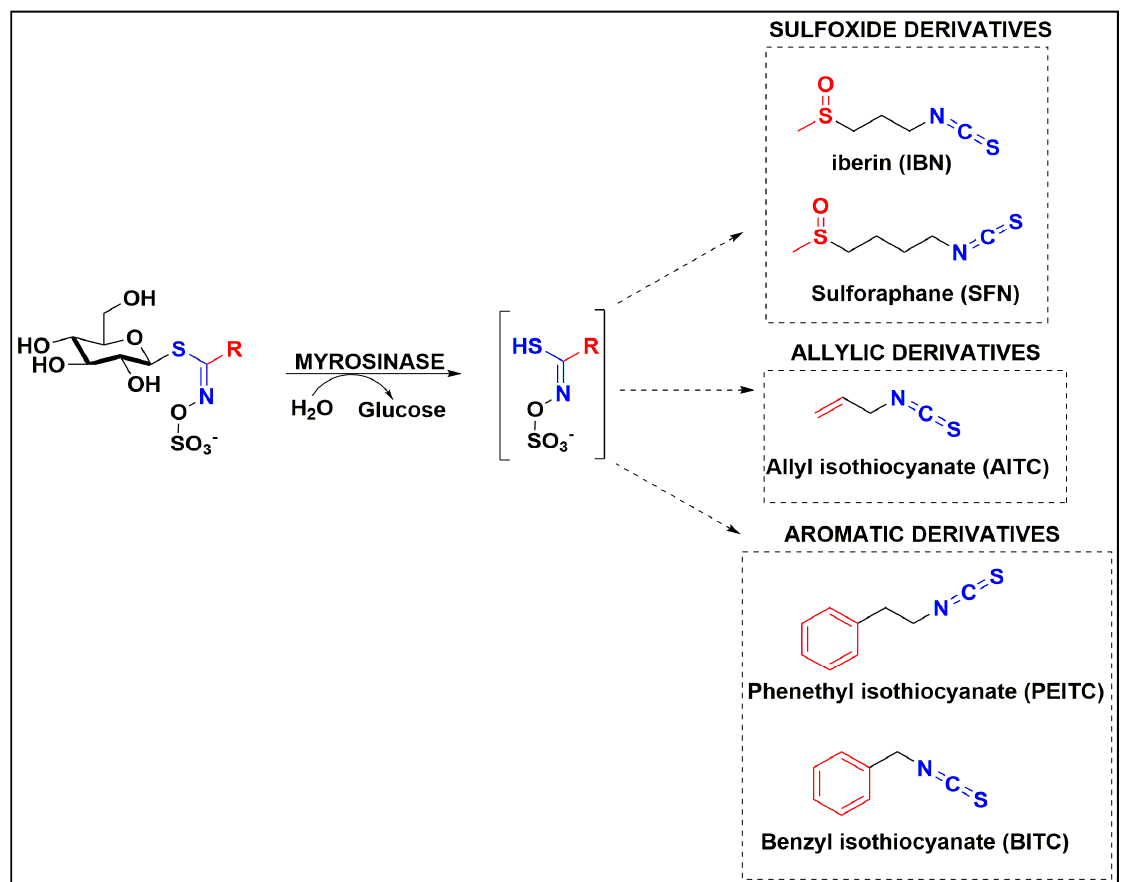
Figure 1. Schematic representation of the enzymatic conversion of glucosinolates into ITCs by the action of myrosinase. Sulfoxide, allylic and aromatic derivatives of glucosinolates are presented as the three major ones along with their respective ITCs namely IBN, SFN, AITC, PEITC and BITC, respectively.